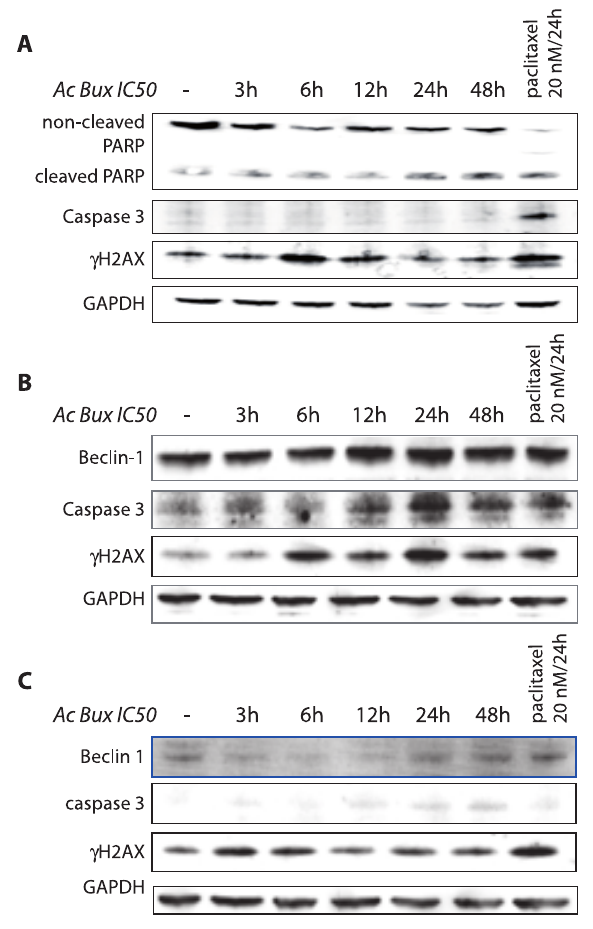
Figure 6. Buxus extract induces apoptosis in MCF10CA1a, T47D and BT-20 breast cancer cell lines. A. Immunoblots of total extracts from MCF10CA1a, revealing the presence of the cleaved from of PARP and c H2AX, hall marks of apoptosis, at the same time, the blot reveals the absence of active caspase 3, demonstrating the occurrence of apoptosis without caspase 3 activation. B. and C. Immunoblots of total extracts from T47D and BT-20, respectively, revealing the presence of the cleaved from of caspase 3 and c H2AX, hallmarks of apoptosis, demonstrating the occurrence of apoptosis and an up-regulation of Beclin-1, proving the occurrence of autophagy at the same time. GAPDH was used as a loading control. Ac Bux: acetonic Buxus extract.